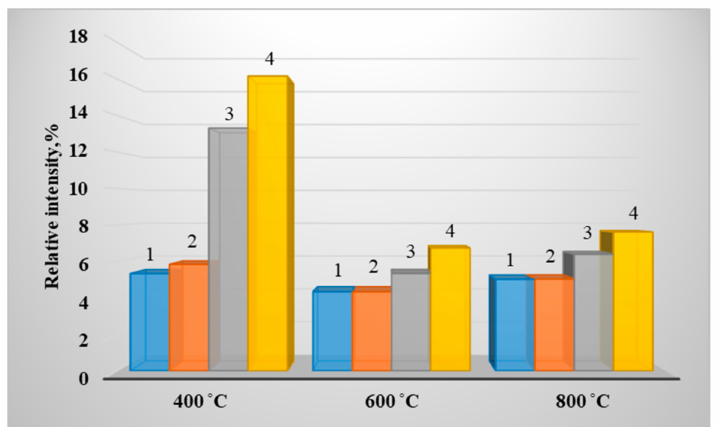
Figure 11. Change in the content of aluminum sulfate in the pyrolysis products of lean coal of grade T, wood and mixtures based on them (with an increase in the mass fraction of wood in the mixture) during pyrolysis of the countable number of fuel particles (5+ 1): 1. Coal T_100%; 2. Coal T_90%/Wood_10%; 3. Coal T_75%/Wood_25%; 4. Coal